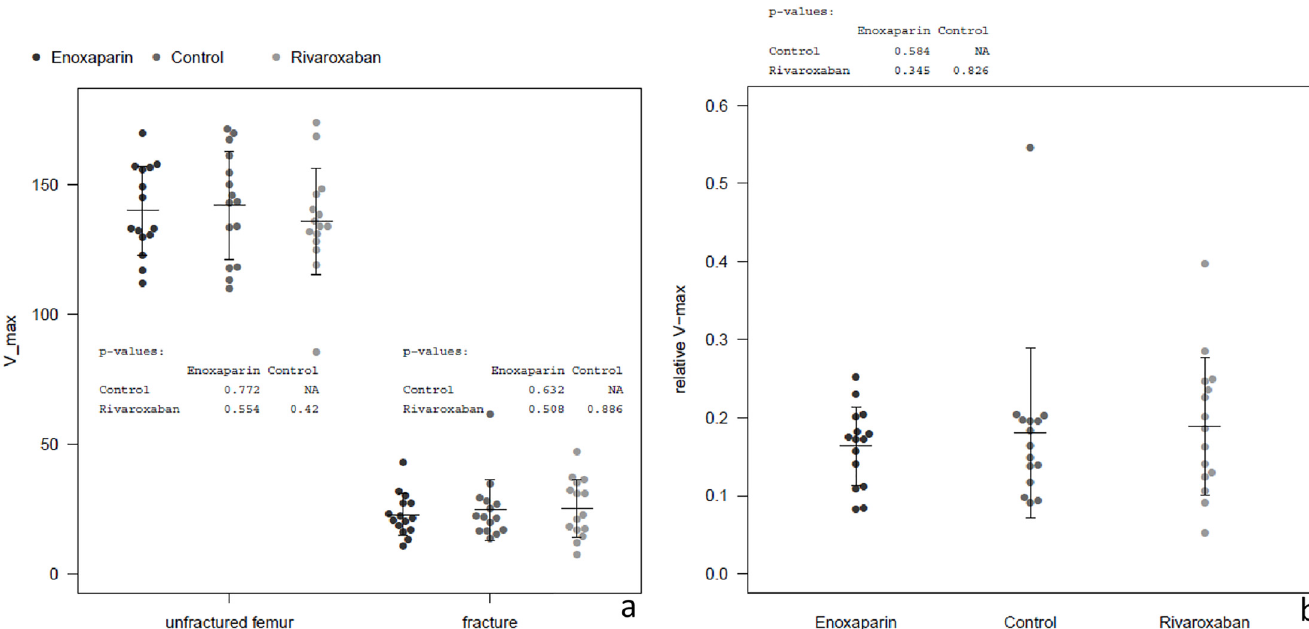
Fig 3. Results Biomechanical Testing, V-max absolute and ratio. (a) Dot-plots of absolute V-max values for controls, Rivaroxaban and Enoxaparin; Control sides (unfractured femur) and experimental sides (fracture). No sign. differences between controls and substances. (b) Dot-plot of ratios fractured to unfractured bones in V-max for controls, Rivaroxaban and Enoxaparin. No sign. differences between controls and substances.